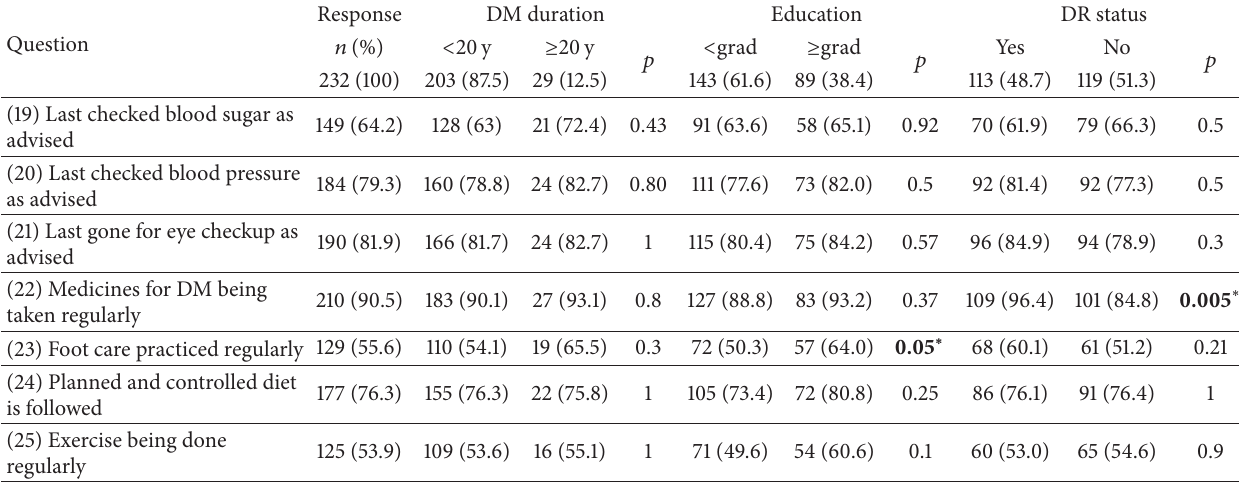
Table 4: Patient response and subgroup analysis of practice